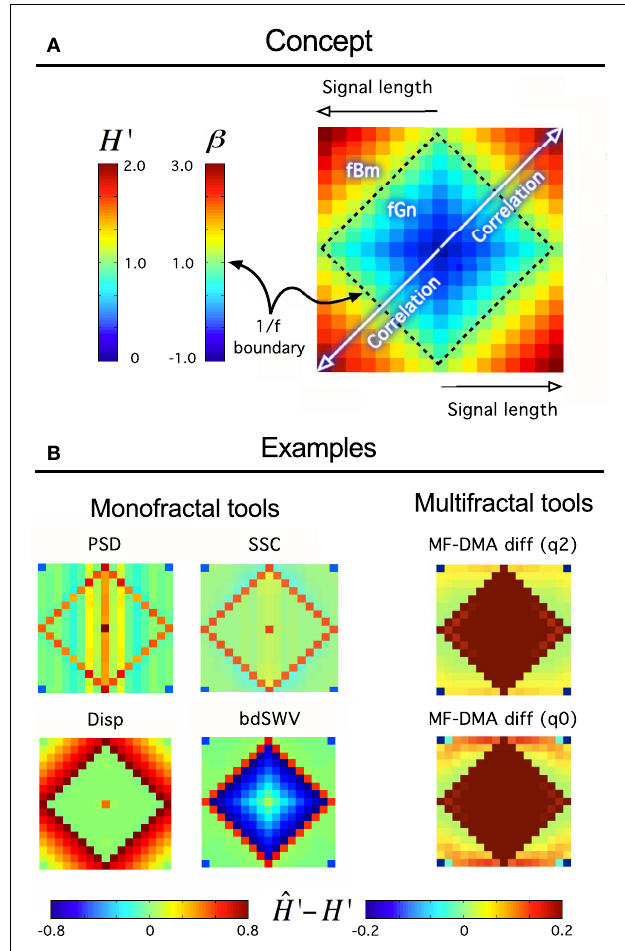
FIGURE 9 | Fractal tool performance vignette. It provides a quick assessment of any fractal time series tool’s performance. As such can be useful as a method of standardization and/or comparison of various algorithms.Technically, a vignette is created as any given fractal time series method evaluates a volume of synthesized time series for a particular fractal parameter.The results are converted to extended H (cid:48) as H (cid:48) = H fGn , H (cid:48) = H fBm + 1 using a conversion table between H and other fractal parameters (Eke et al., 2002).The signals are generated for a range of length, L [ L min , L max ] in increments of ∆ L , and for the full range of the fGn/fBm dichotomy at β or H (cid:48) at given increments of the exponent, ∆ H’ by the DHM method (Davies and Harte, 1987; Eke et al., 2000).The volume is created from these signals arranged in a square raster, which will correspond to one of four identical quadrants of the vignette. Once the analysis by a fractal tool has been carried out the results are plotted in a square array as shown in (A) such a way that fGn signals occupy a square created by the four identical quadrants.The 1/ f boundary separating the fGn from the fBm range can be easily identified as plotted with a midscale color. Warmer colors indicate over-, cooler colors underestimation of the scaling exponent at the particular signal length or degree of correlation.When applied to class-independent or dependent methods (B) , like PSD, SSC ( B , upper half) or Disp (dispersional analysis) and bdSWV (bridge detrended ScaledWindowVariance) ( B , lower half), respectively, an immediate conclusion on signal performance can be drawn: PSD and SSC can be used for fGn and fBm signals alike (except in the vicinity of the 1/ f boundary) and SSC is more precise. Disp (Bassingthwaighte and Raymond, 1995; Eke et al., 2000, 2002) and bdSWV (Eke et al., 2000, 2002),